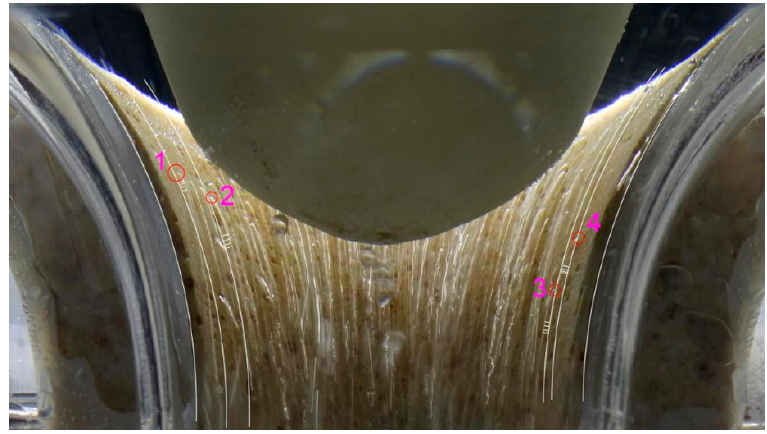
Figure 12. Schematic diagram of representative pores to measure the distances from bubble chains on the inner surface of the nozzle.